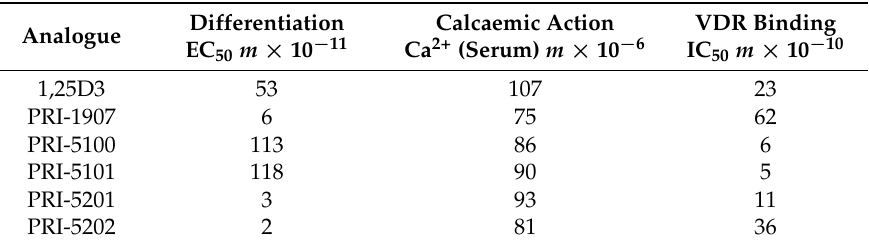
Figure 4. The side-chain extended and rigidified analogues of 1 α ,25-dihydroxyvitamin D 2 (PRI-1906 and PRI-1907) and their (24 Z ) geometric isomers (PRI-1916 and PRI-1917). Table 1. Differentiating potency, calcemic action, and binding to the receptor for vitamin D (VDR) of PRI analogues of 1 α ,25-dihydroxyvitamin D 2